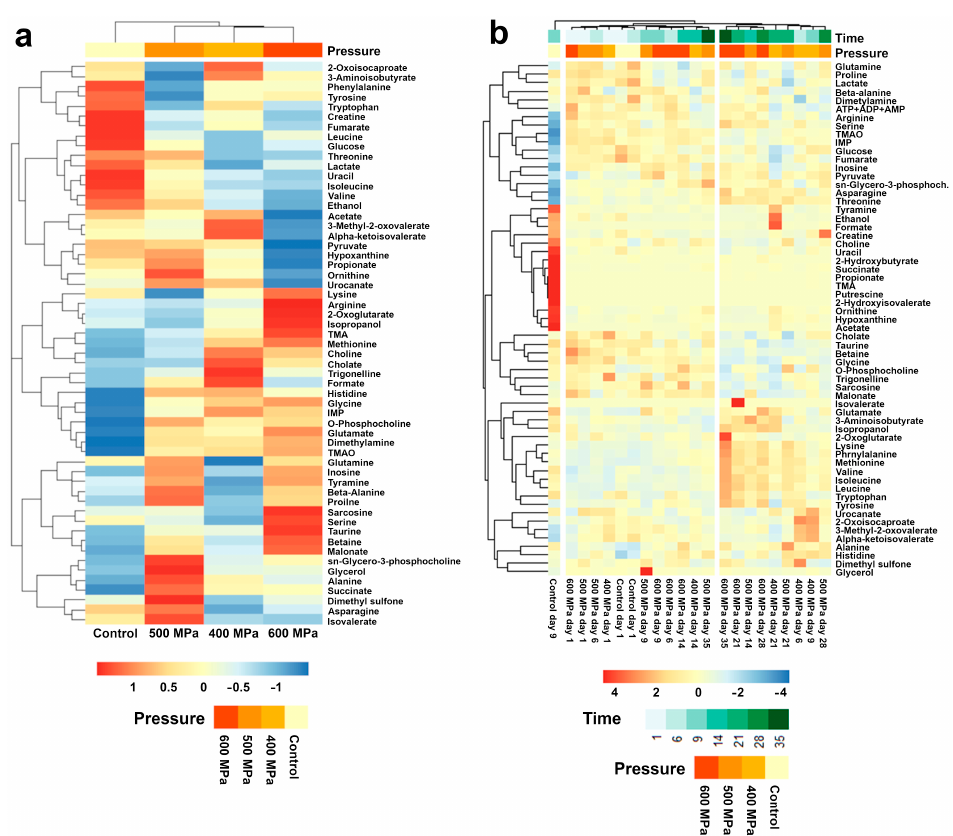
Figure 2. Heatmap visualization of the differential concentrations of metabolites among striped prawn samples subjected to different treatments on day 1 ( a ) and during storage ( b ). Red and green squares highlight metabolites more and less concentrated, respectively, than the average, with the depth of colors indicating greater differences.